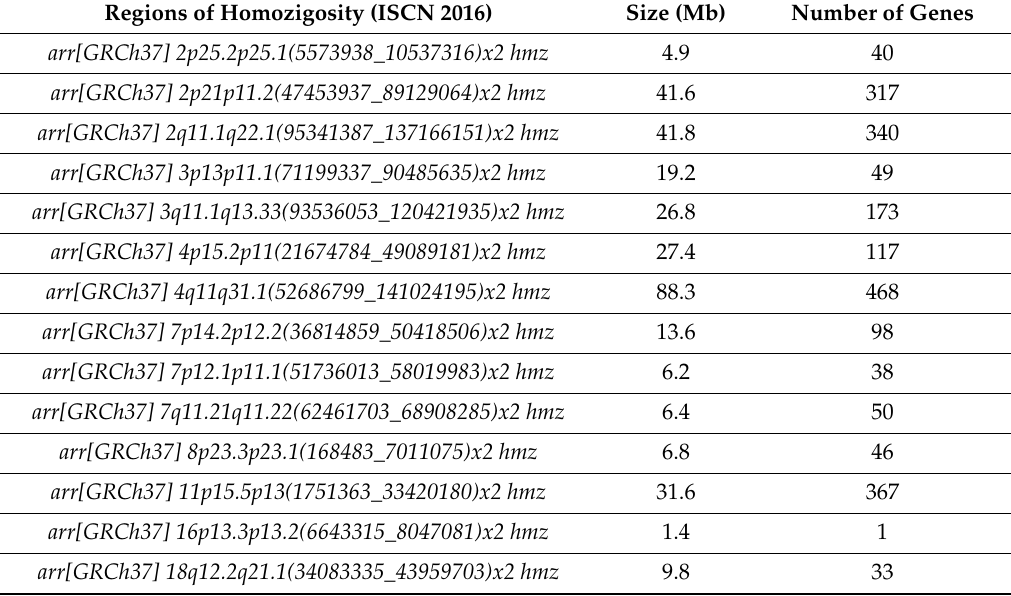
Table 1. List of regions of homozygosity (ROHs) identified in the proband genome according to the International System for Human Cytogenetic Nomenclature (ISCN 2016). Size and number of genes included in each ROH are indicated. All genomic coordinates were based on the GRCh37 / hg19 build of the Human